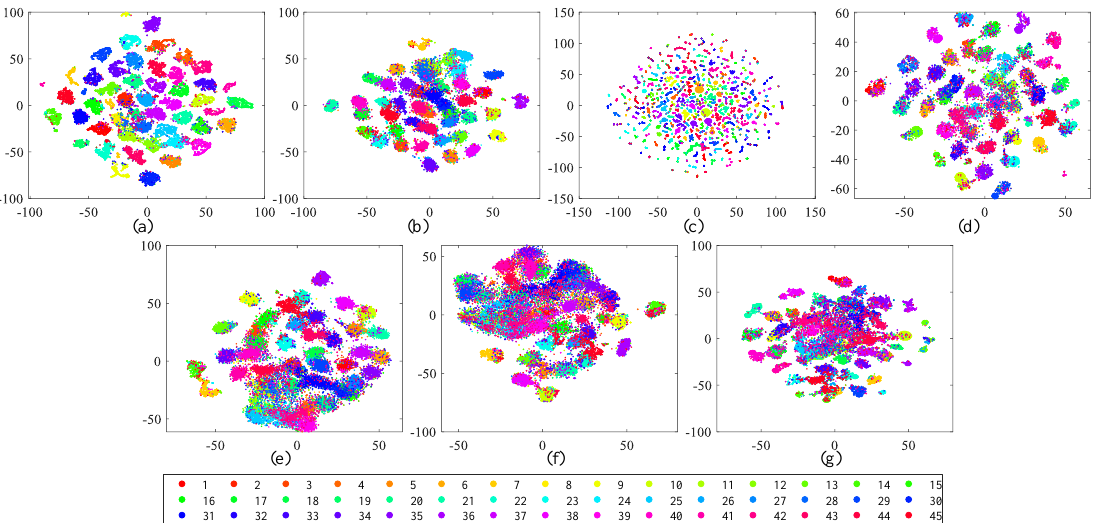
Figure 16. Two-dimensional scatterplots of different hash codes (128 bits) obtained by t-SNE over NWPU with 45 semantic scenes. The relationships between number ID and scenes can be found in Table 3: ( a ) SDAH (Our method); ( b ) SSDH; ( c ) BTNSPLH; ( d ) KSH; ( e ) DQH; ( f ) DHN; and ( g ) DSH.